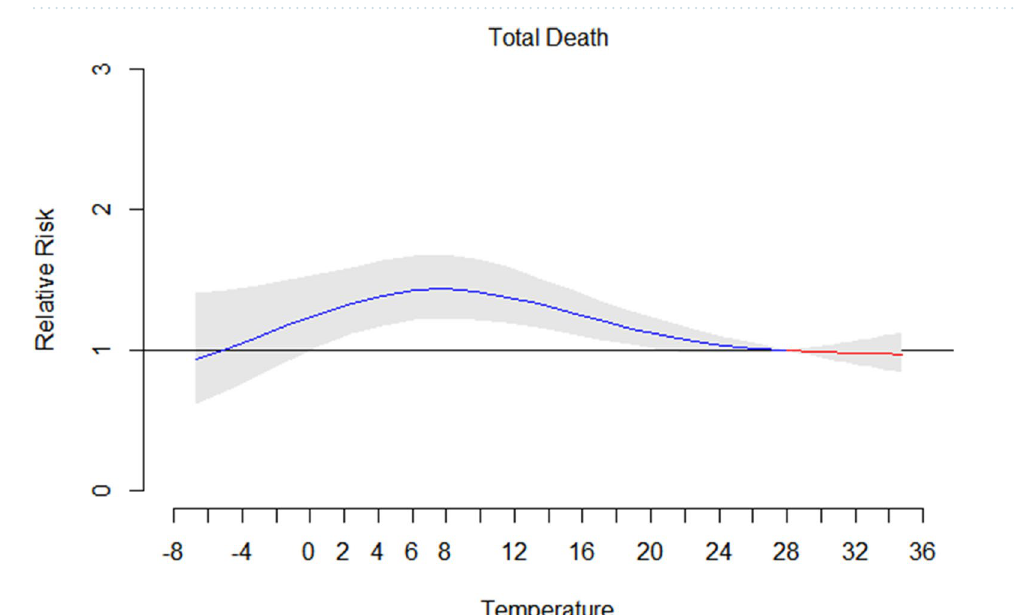
Figure 2. Estimated temperature effects (mean temperature, lag 0–21) by total in-hospital death,